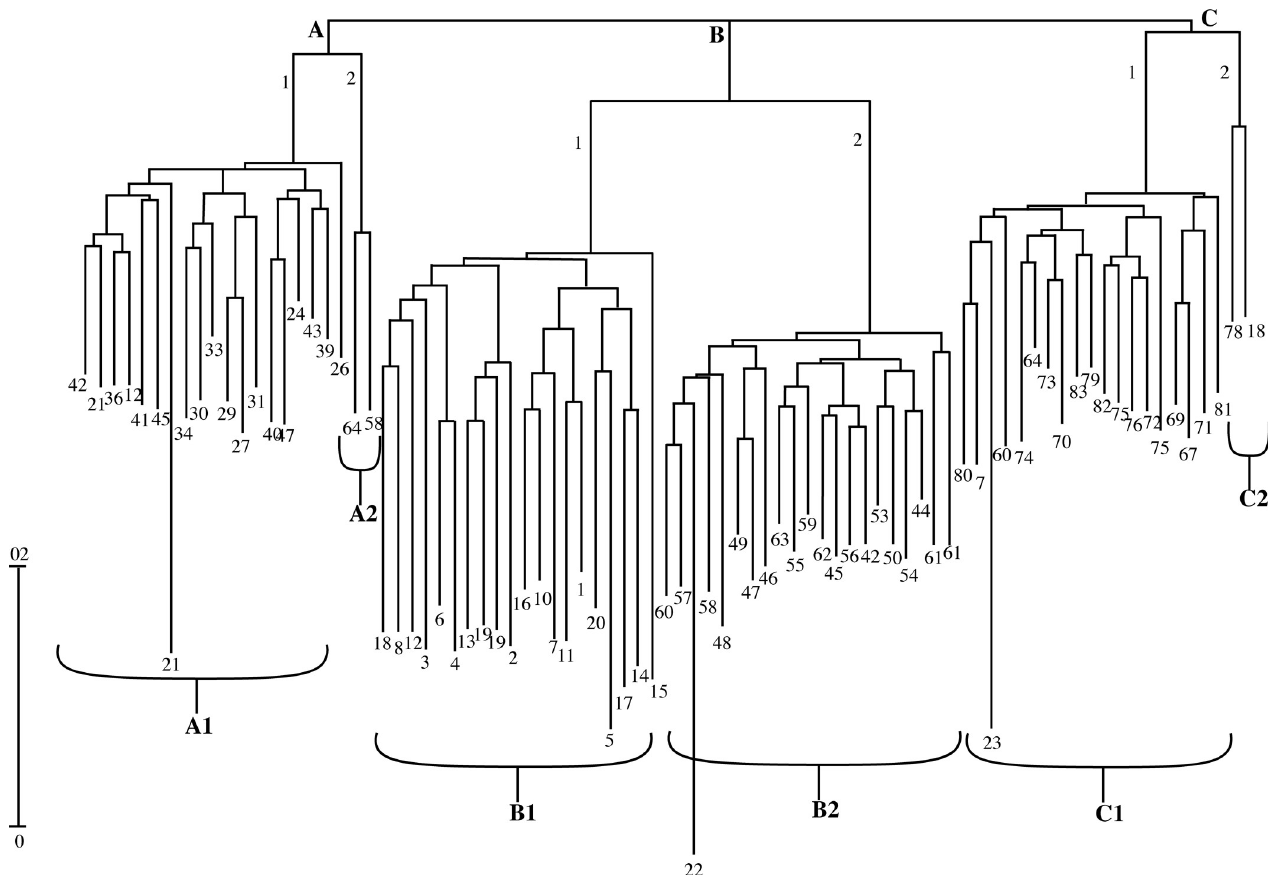
Fig 3. Dendrogram of sunflower genotype distribution based on microsatellite markers.